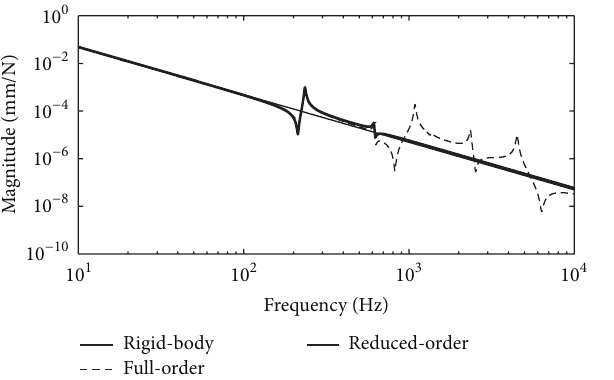
Figure 4: System block